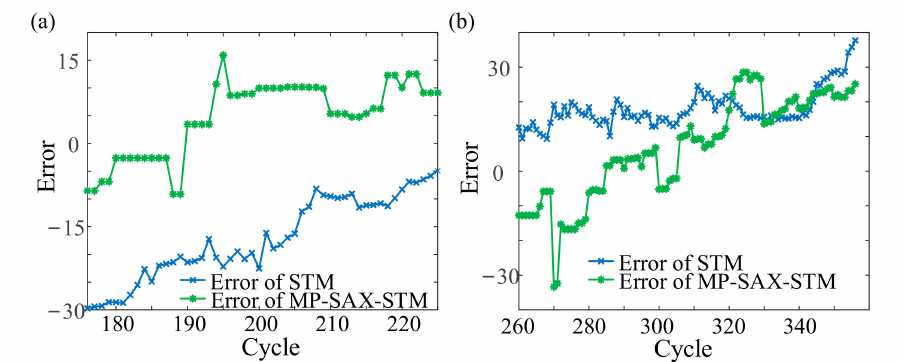
Figure 11. RUL error of the single tested sample. ( a ) Set #2. ( b ) Set